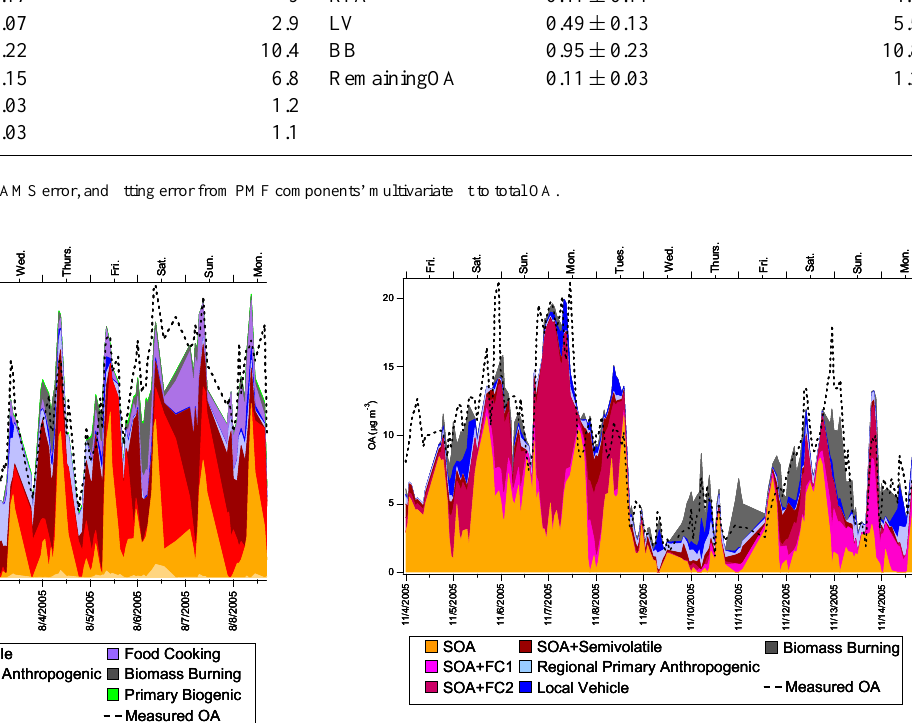
Fig. 8. Factor contributions to PM 1 organic aerosol mass concen- trations during the summer focus period (29 July–8 August). Dates are labeled at the beginning (midnight PST) of that day.